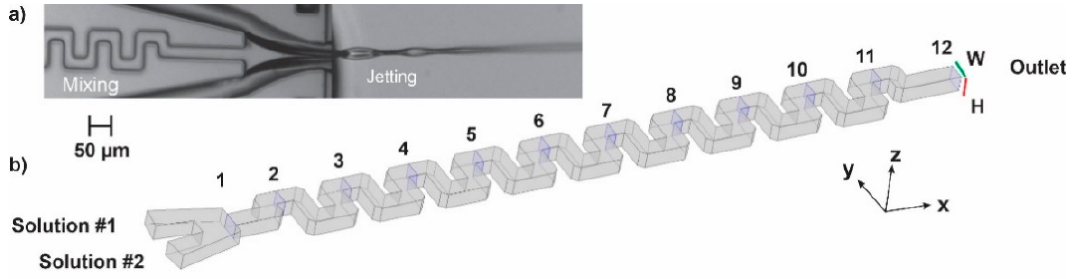
Figure 2. The mixing component of the microfluidic mix-and-inject device, ( a ) optical microscope image of the serpentine mixer fabricated using SU8 on glass; ( b ) schematic of the simulated geometry employed for the present study. The points at which the device characteristics (e.g., concentration) were probed are shown by the light blue squares in the cross-section of the mixer channel.